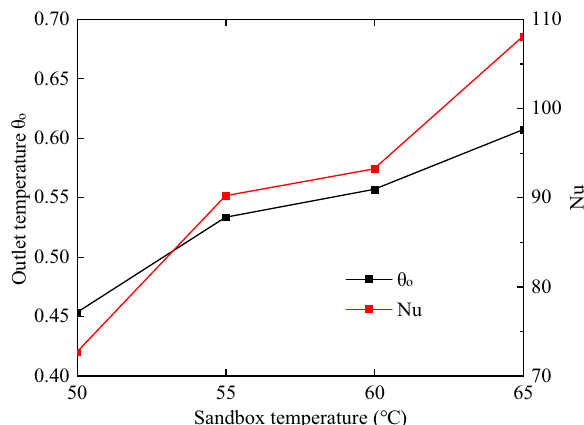
Fig. 20 Variation of average outlet temperature and Nu with sandbox temperature in backward flow